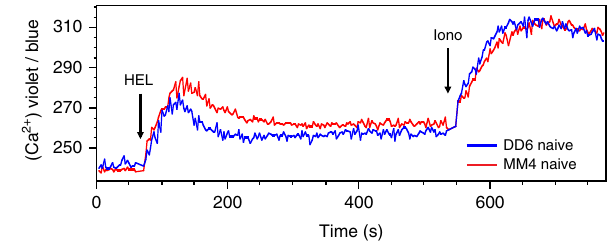
Figure 1 | IgD and IgM both signal intracellular calcium upon binding monovalent antigen. Mixtures of splenic naı¨ve B cells from DD6 CD45.2 mice expressing only IgD HEL and MM4 CD45.1 heterozygous mice with only IgM HEL were loaded with the intracellular calcium indicator, Indo-1 and analysed by flow cytometry using gating strategy shown in Supplementary Fig. 1. Arrows indicate when HEL (5 m gml (cid:2) 1 ) or ionomycin was added. Results are representative of three stimulations and two independent experiments with MM4 and DD6 mice of reversed CD45.1/CD45.2 genotypes. NATURE COMMUNICATIONS|7:13381|DOI: